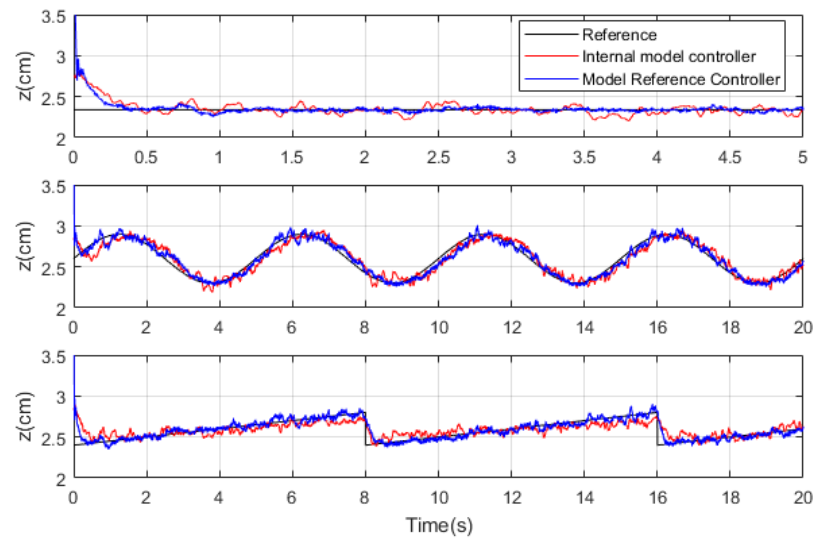
Figure 29. Comparison of the system responses with the internal model and reference model con- trollers. Table 13. ISE, IAE, and ITAE values for the internal model and the model reference controller. Step Sine Saw Total